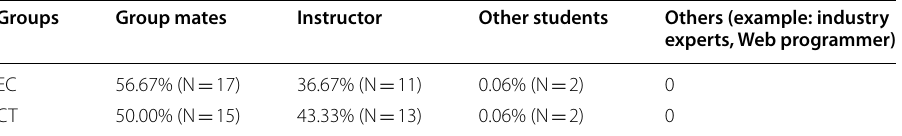
Table 7 Constructive feedback source